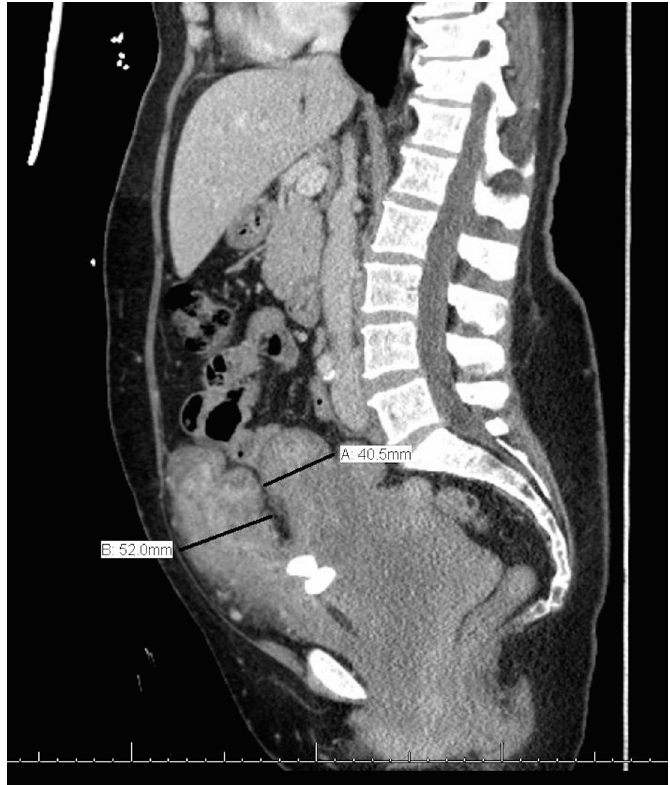
Figure 2. Computed tomography of enlarged, nondistended urinary bladder with diffusely thickened wall shown in sagittal view after placement of a urinary